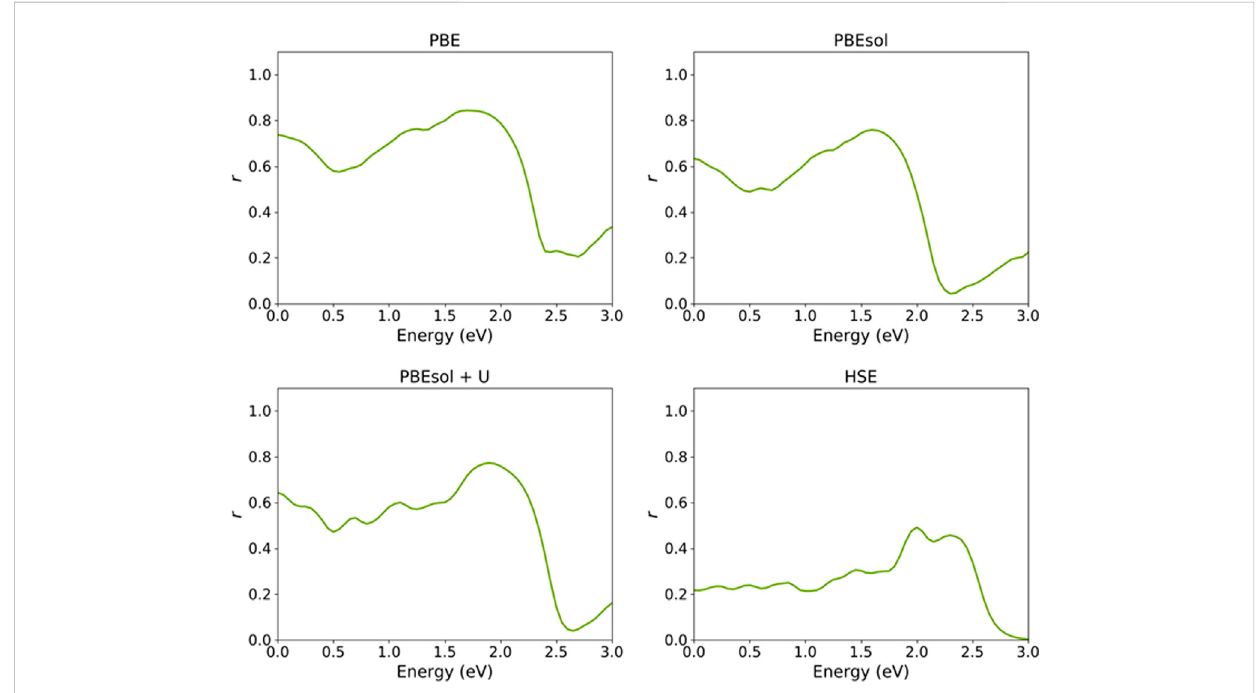
FIGURE 8 Re fl ectivity spectrum of the VO 2 (M) polymorph as a function of the energy (eV), predicted by semi-local PBE, PBEsol, PBEsol + U, and hybrid HSE functionals.